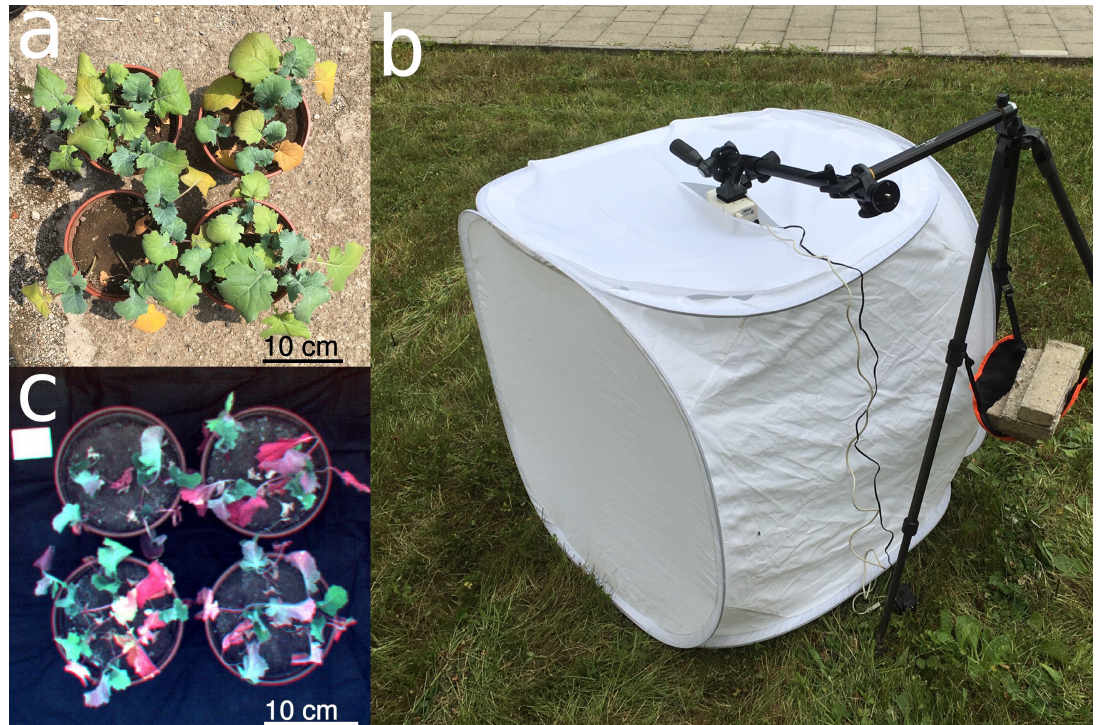
Figure 1. Material used in the experiment. ( a ) Oilseed rape in pots 16 days before the spectral data collection. ( b ) Imaging setup with the photo tent and the hyperspectral camera on the tripod. ( c ) False-colour composite rendering of one of the hyperspectral data cubes employed in the pixel labelling.